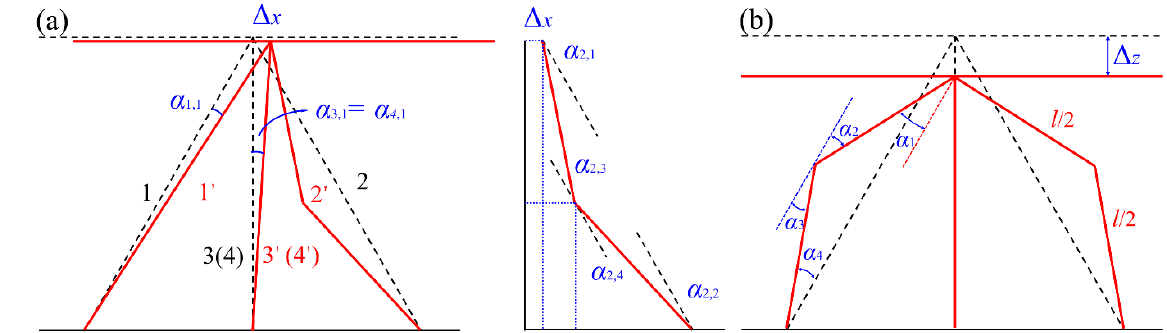
Figure 10. Sketch of the plastic deformation mode for the truss under shearing ( a ) and compressive ( b ) stress.